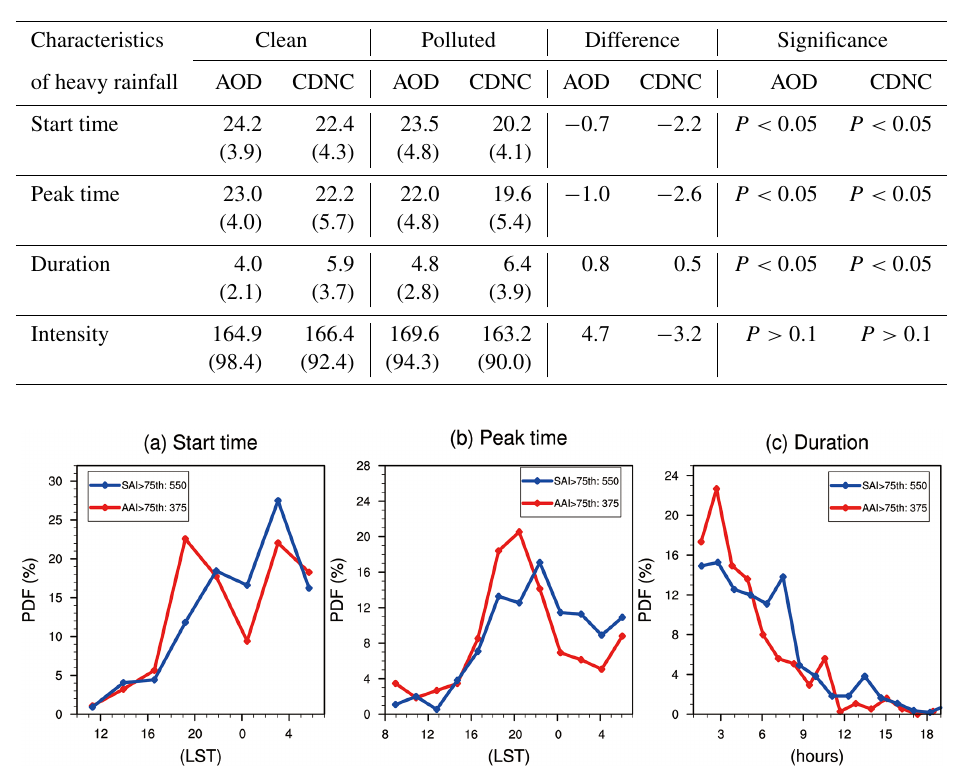
Table 2. The mean values of start time (units: LST), peak time (units: LST), duration (units: hours) and intensity (units: 0.1mmh − 1 ) of heavy rainfall, respectively, on the clean and polluted conditions using two indicators of AOD and CDNC, and their differences (polluted minus clean) and significances. The numbers in the brackets stand for the standard deviations on the means. “ P < 0 . 05” stands for the difference that has passed the significance test of 95%, and “ P > 0 . 1” stands for the difference that did not pass the significance test of 90%.